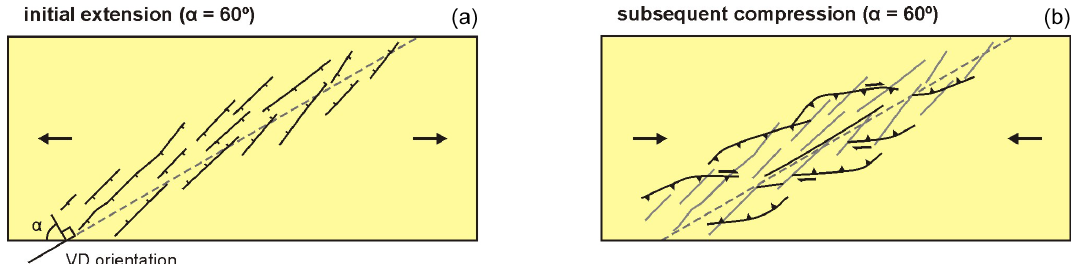
Figure 12. Top view of an inversion model involving a base plate set-up with brittle–viscous layering and (a) initial oblique extension leading to a series of en echelon normal faults, followed by (b) subsequent oblique inversion leading to (oblique) thrusting and strike-slip faulting. Inspired by Ustaszewski et al.